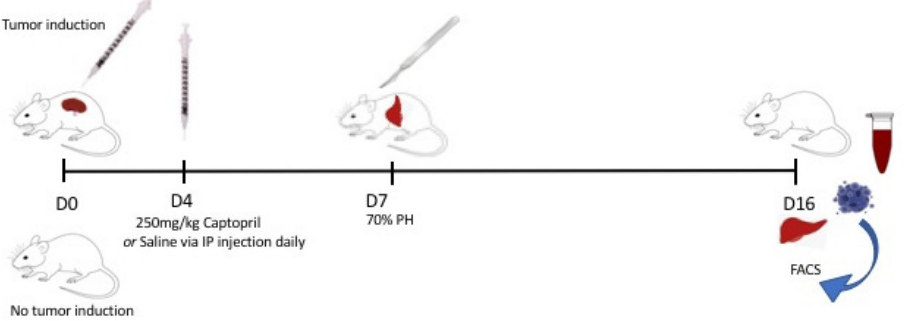
Figure 6. Experimental methodology. Mice were allocated to either tumour induction or no tumour induction groups, and this was performed on Day 0. From Day 4 to Day 16, half the mice in each group received treatment with intraperitoneal injections of captopril 250 mg/kg/day and the other half received intraperitoneal injections of saline (control). On Day 7, all mice underwent a 70% partial hepatectomy. Mice were culled on Day 16, and liver and tumour (if applicable) samples were retrieved for